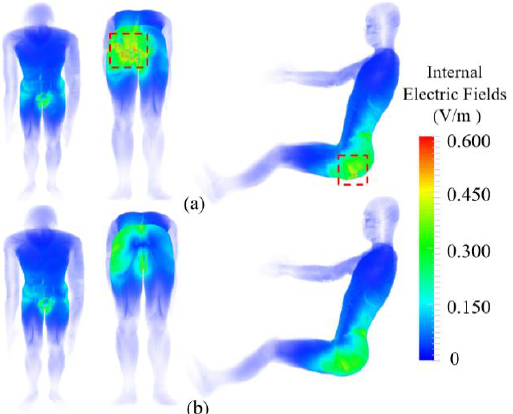
Figure 7. Electric field distribution in the driver model for the CFRP vehicle, ( a ) with both woofer and tweeter and ( b ) without loudspeakers.